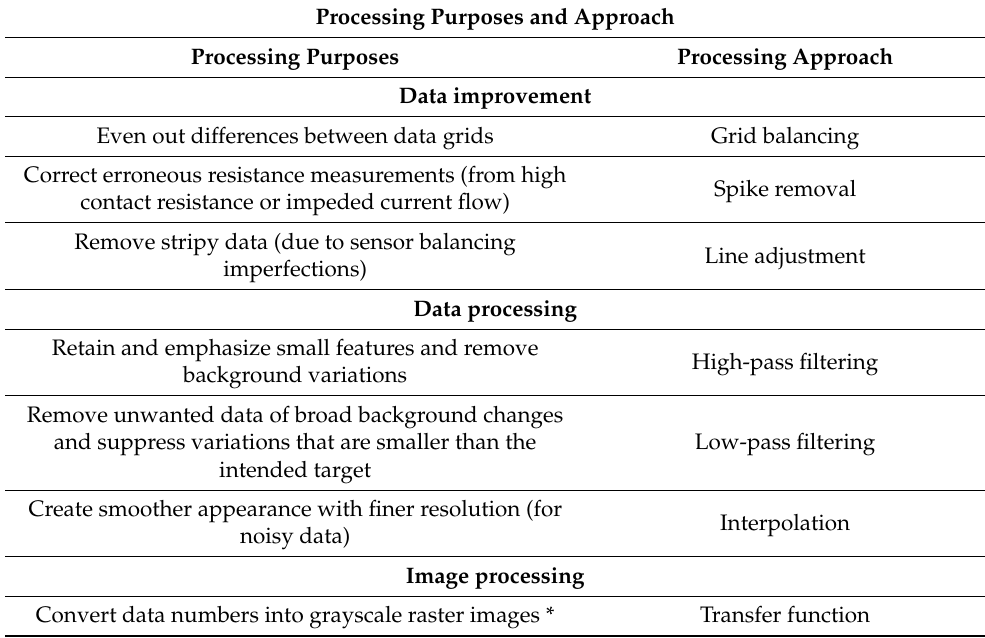
Table 2. List of processing objectives and the method that should be used to accomplish them for FPR data